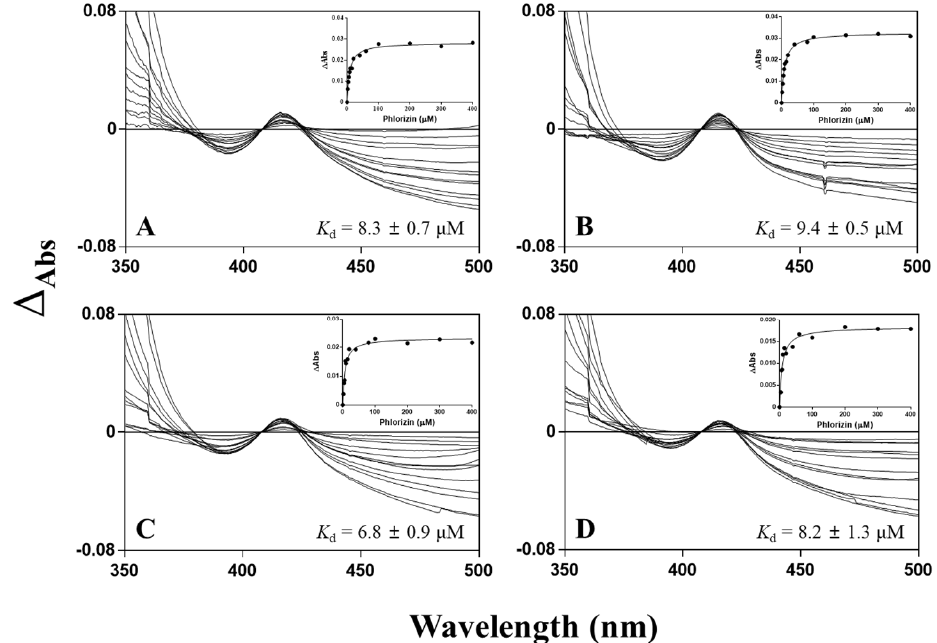
Figure 8. Spectral binding titration of CYP102A1 with phlorizin. The reactions contained 0–400 µ M of phlorizin in potassium phosphate (100 mM, pH 7.4) and 2 µ M P450 of M221 ( A ), M371 ( B ), M620 ( C ), and M850 ( D ). Insets show the plots of phlorizin absorption change calculation from different spectra obtained by subtraction of the staring spectrum from subsequently measured spectra collected at each phlorizin concentration in the titration.